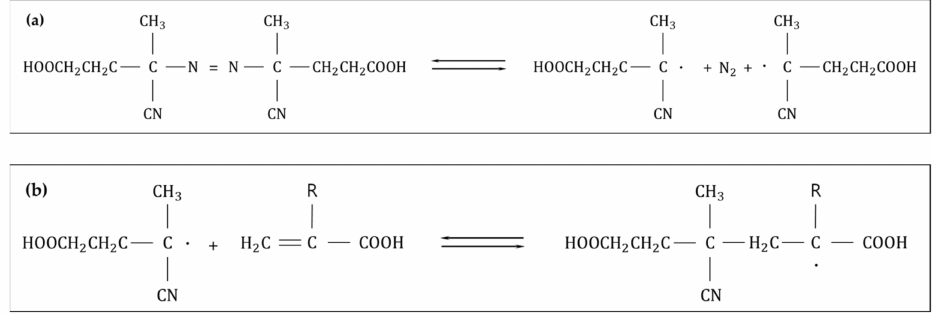
Figure 2. Radical mechanism initiation: ( a ) initiator decomposition and ( b ) initiation reaction.